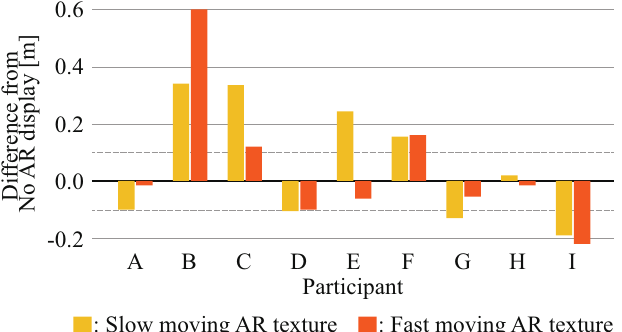
Figure 25. Results of difference between w/AR and w/o AR. By changing the texture with AR, we were able to influence people to walk in the direction of the flowing stripes, or to have difficulty walking. However, we found that it was difficult to give the desired effect to all people. Since the viewing angle of HoloLens display was very narrow, the range of the AR texture was also narrow. It is important to conduct experiments in different environments using AR display devices with a wider viewing angle in the